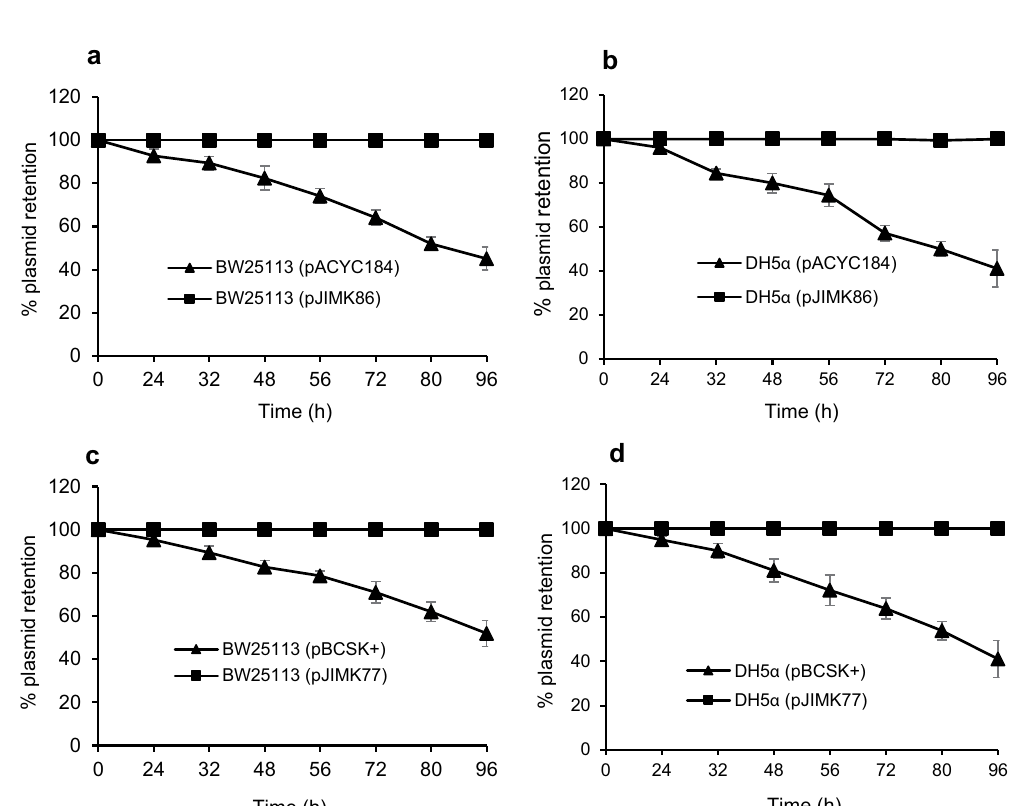
Figure 2. Plasmid stability assay. Plasmid stability was assessed for cloned ParDE I TA system in low copy ( a , b ) and high copy number plasmids ( c , d ) in E. coli BW25113 ( a , c ) and DH5 α ( b , d ), expressed as relative plasmid retention over time. Plasmids carrying cloned ParDE I TA were very stable ( ■ ), irrespective of plasmid type and host strain, while ~60% of control plasmids (vector only) were lost ( ▲ ) within 96 h without antibiotic selection. Each experiment was repeated three times, and the mean values with standard deviations (error bars) are